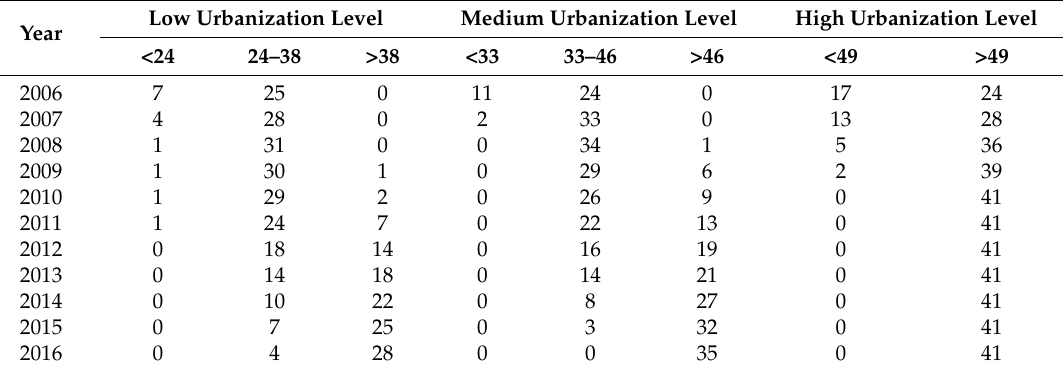
Table 6. Number of cities located in different population urbanization